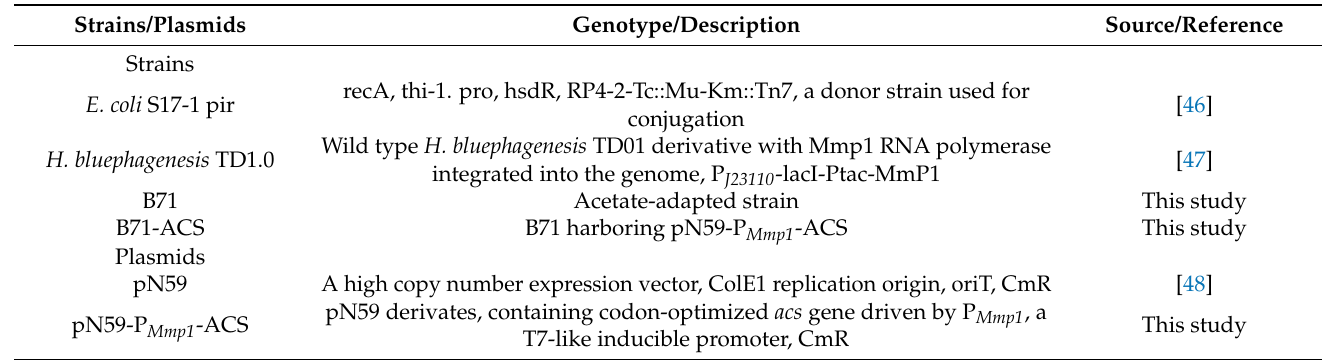
Table 3. Bacterial strains and plasmids used in this